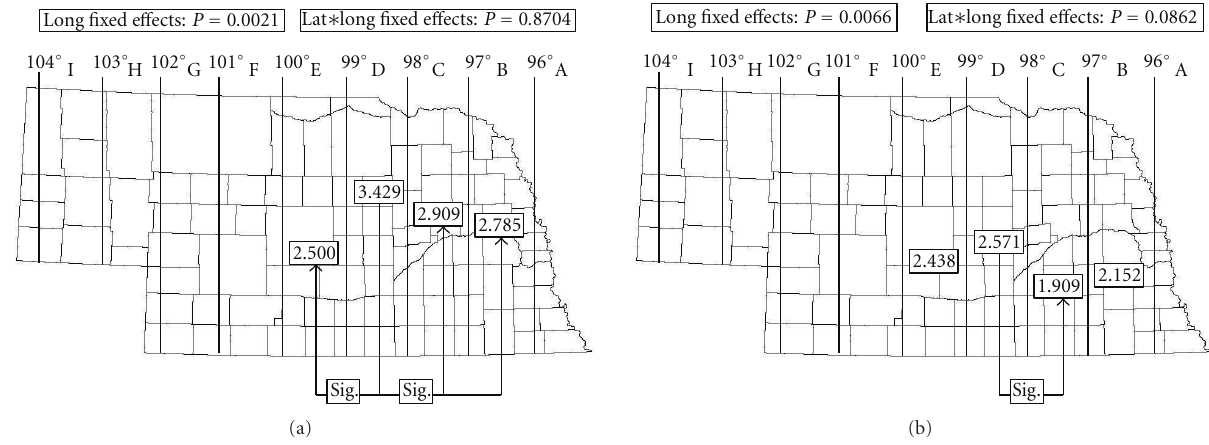
Figure 2: Elytral maculation character states for C. limbalis (adapted from [18]). (a) Middle band and (b) apical lunule. Total maculation and humeral lunule not presented as no significant di ff erences found. Significant di ff erences between longitudes shown by arrows and mean value presented in each longitudinal grouping. Fixed e ff ects and e ff ects of latitude by longitude interactions presented at top of each